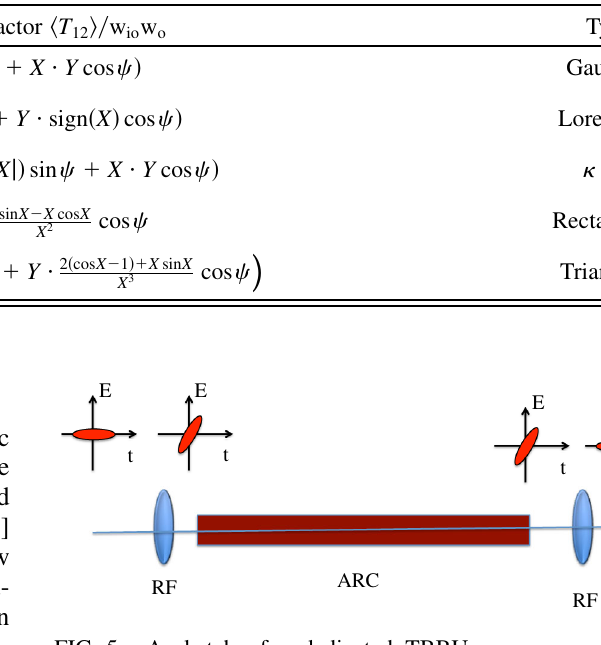
FIG. 5. A sketch of a dedicated TBBU suppressor: One rf cavity gives an energy chirp to the electron beam at the entrance to the arc, and the other cavity removes the chirp.